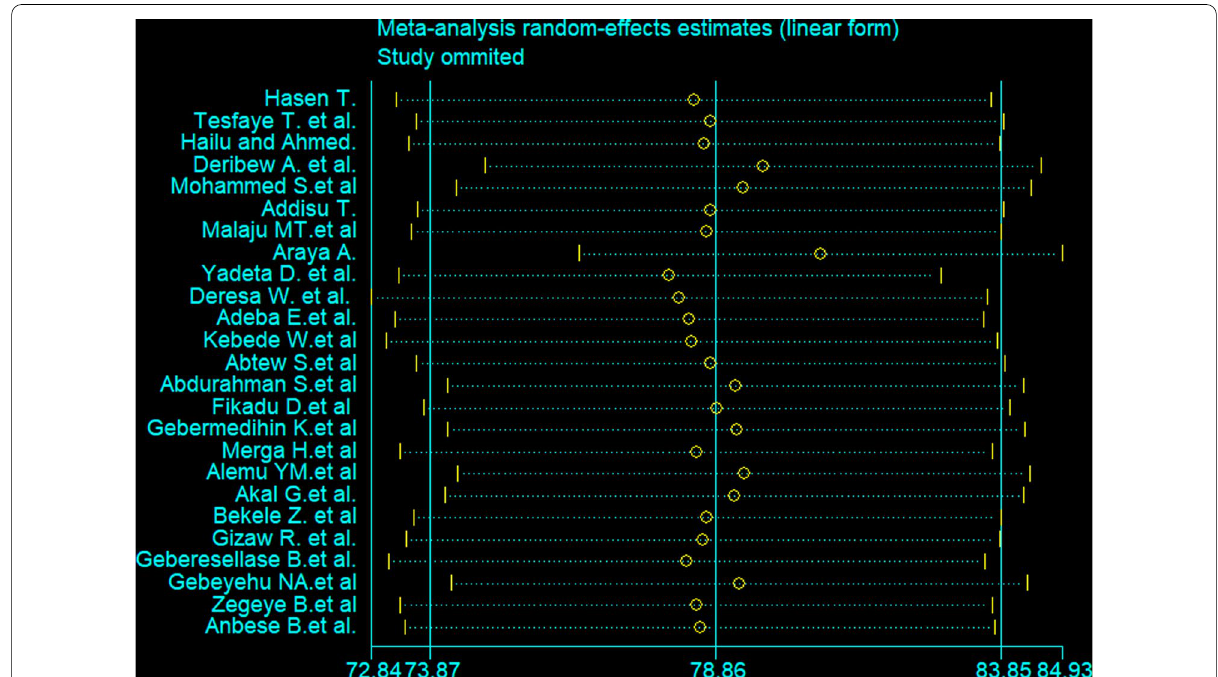
Fig. 5 Sensitivity analysis of studies included for pooled utilization provider initiated HIV testing and counselling in